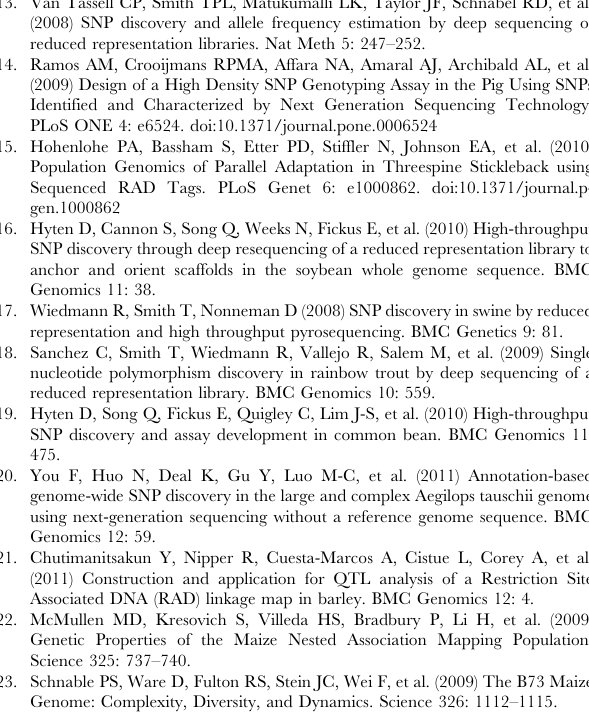
Figure S13 Two competing evolutionary models of upland 4 6 switchgrass. (A) Upland 4 6 arose from upland 8 6 switchgrass. (B) Upland 4 6 arose from lowland 4 6 switchgrass. (TIF) Figure S14 Migration patterns of switchgrass. (TIF) Table S1 Background information on the germplasm used in study. (PDF) Table S2 Individual clones sequenced in the association panel. (PDF) Table S3 Quality of linkage group clustering at different call